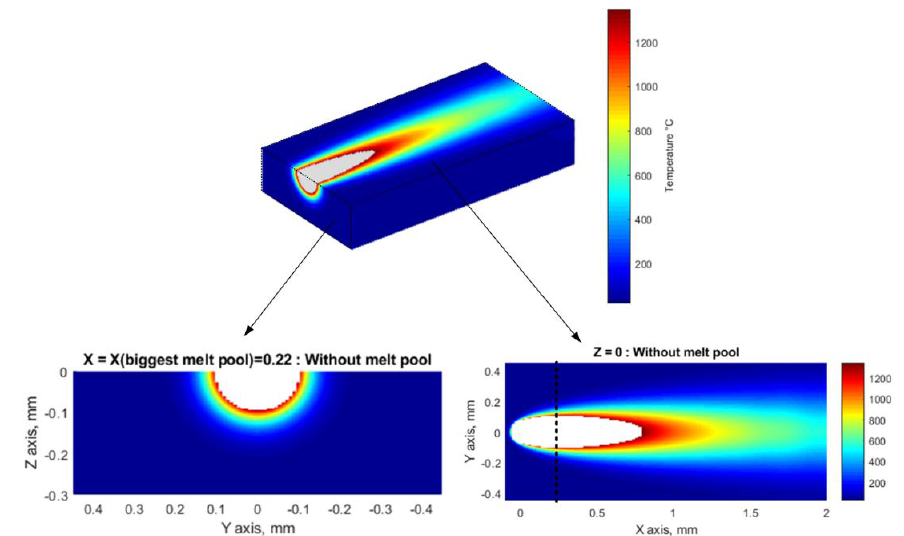
Figure 2. Melt pool dimensions for IN625 powder when P = 270 W, v = 1000 mm/s, and t = 40 µ m; the melt pool width and depth are delimited by the alloy melting temperature.